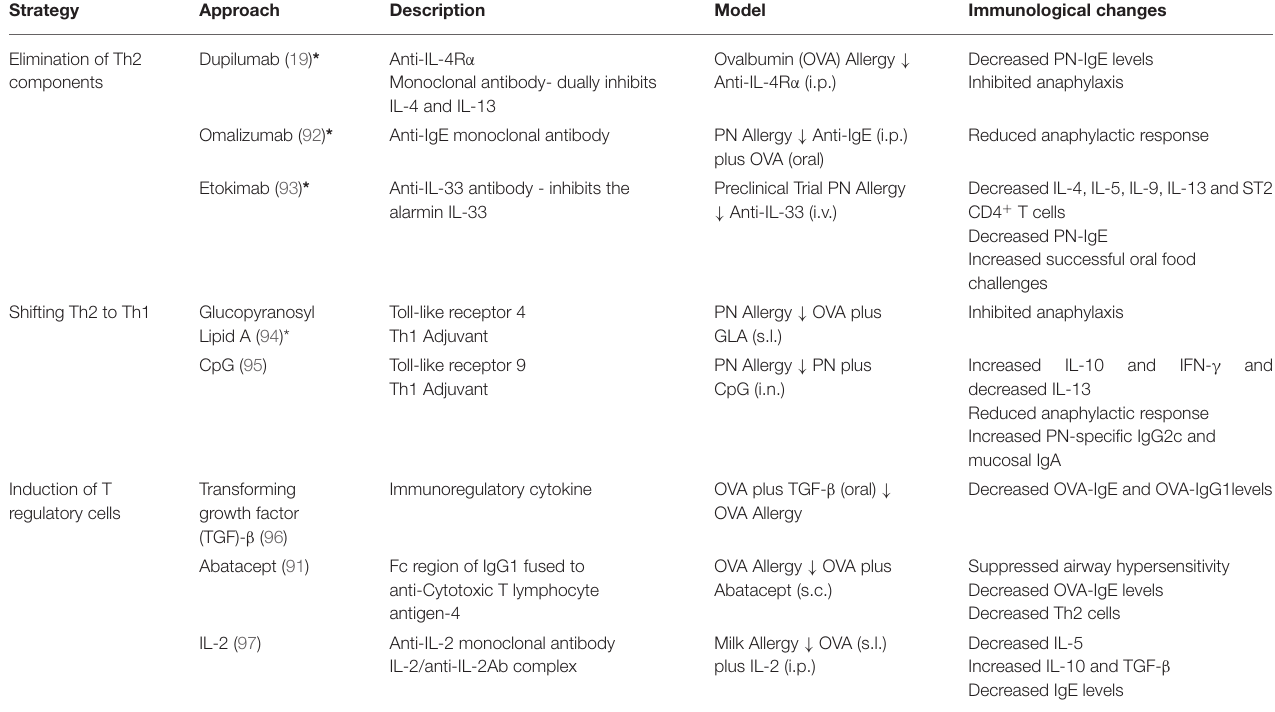
TABLE 2 | Current treatments under investigation for food